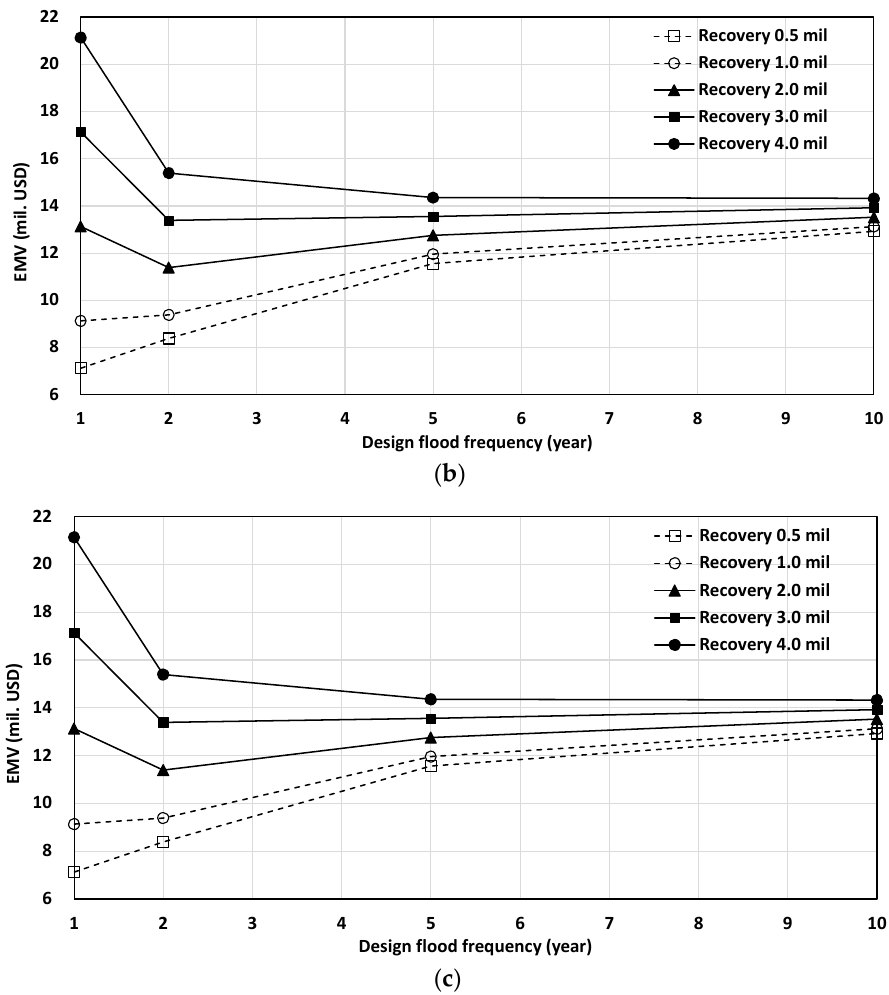
Figure 7. EMV of diversion structure according to the period of use (delay LD: 1.5%). ( a ) Period of use: 3 years. ( b ) Period of use: 4 years. ( c ) Period of use: 5 years.